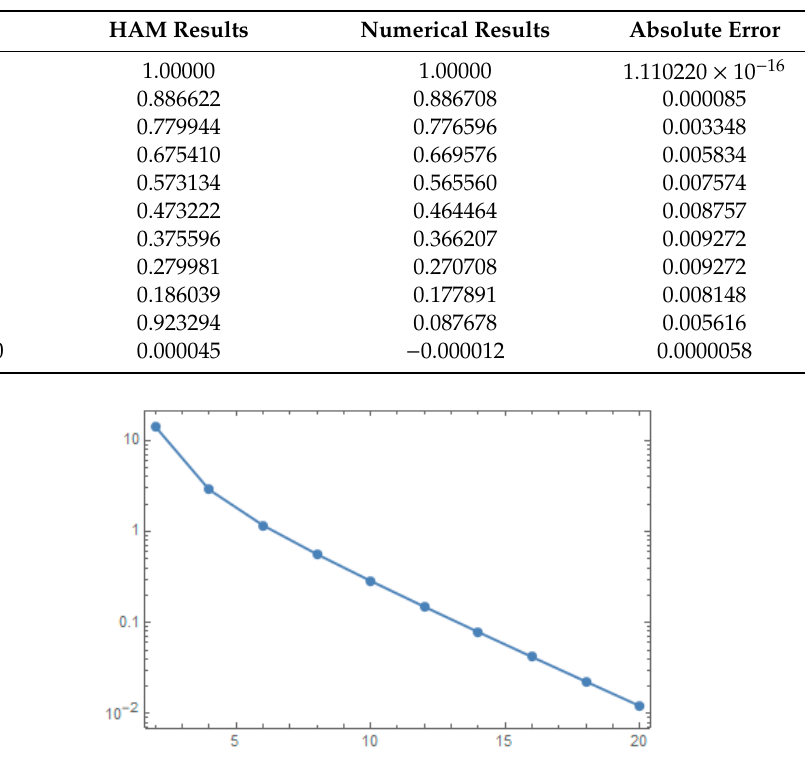
Table 6. Comparison results for lamina-shaped nanoparticles.